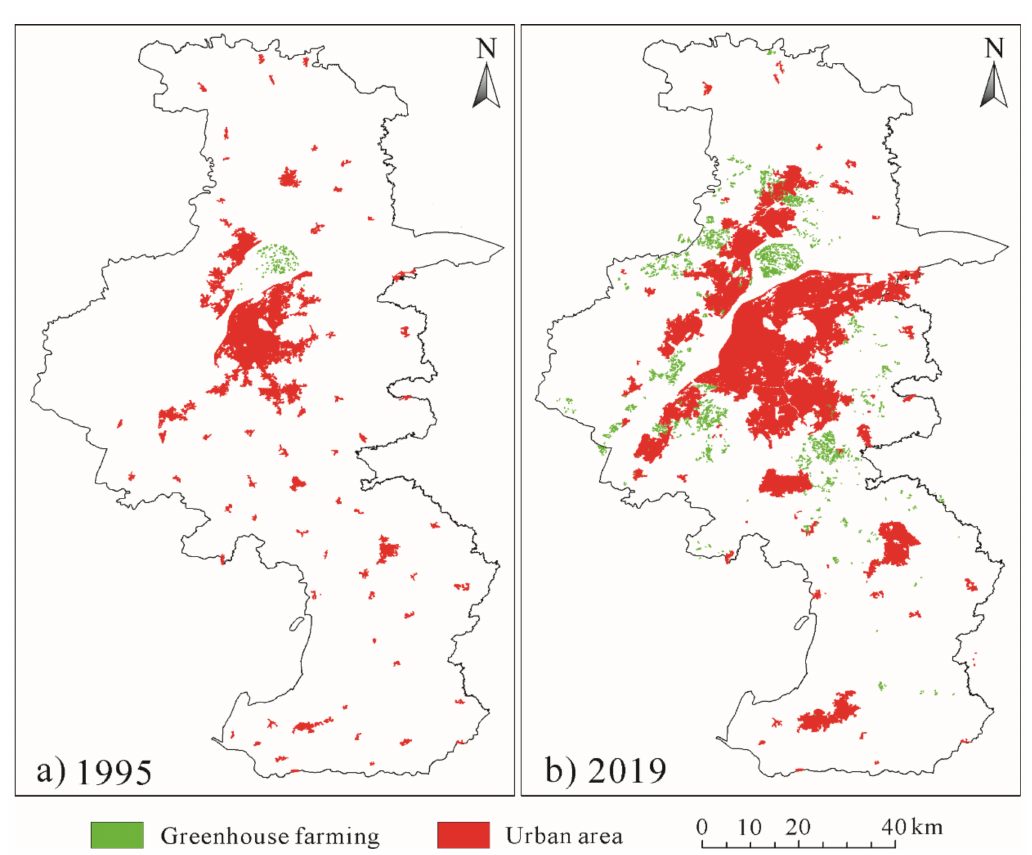
Figure 3. Greenhouse farming expansion in Nanjing from 1995 to 2019. (Source: Adapted from Zhong et al.